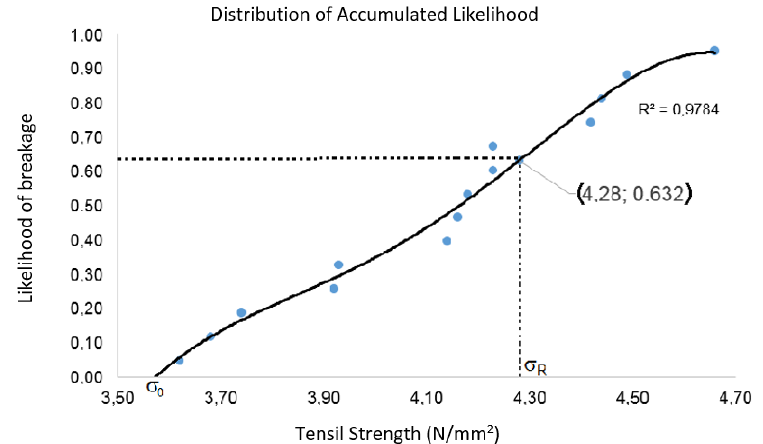
Figure 7. Distribution of the accumulated likelihood (PBB).